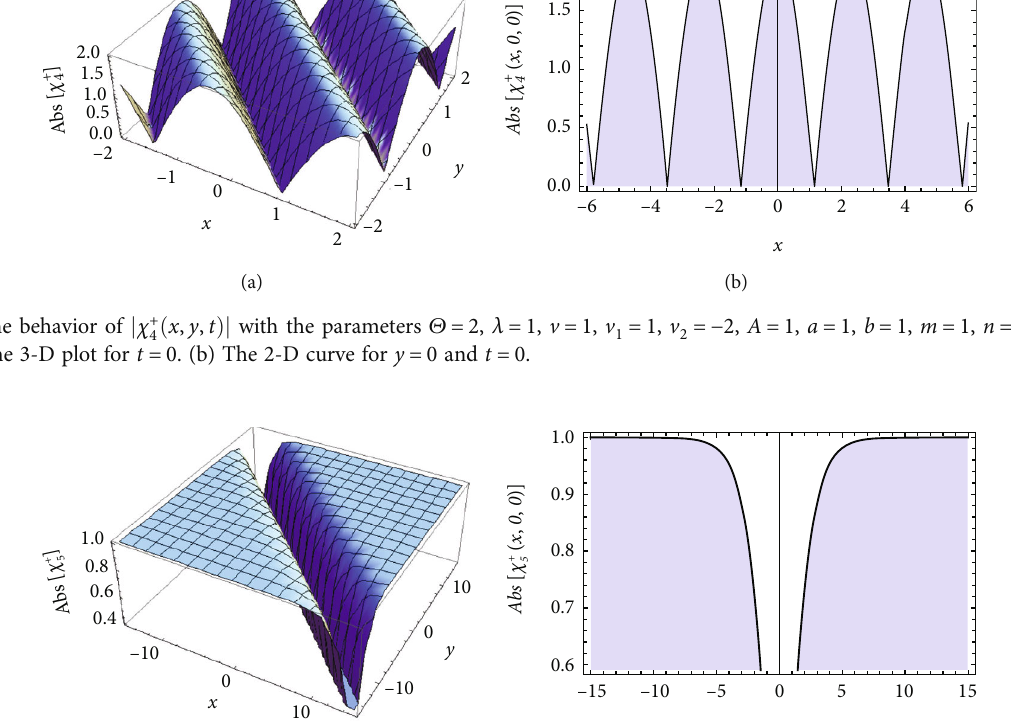
= 1 , v = 1 , A = 1 , a = 1 , b = 1 , m = 1 , n = 1 , k = 4 , and ϕ 1 2